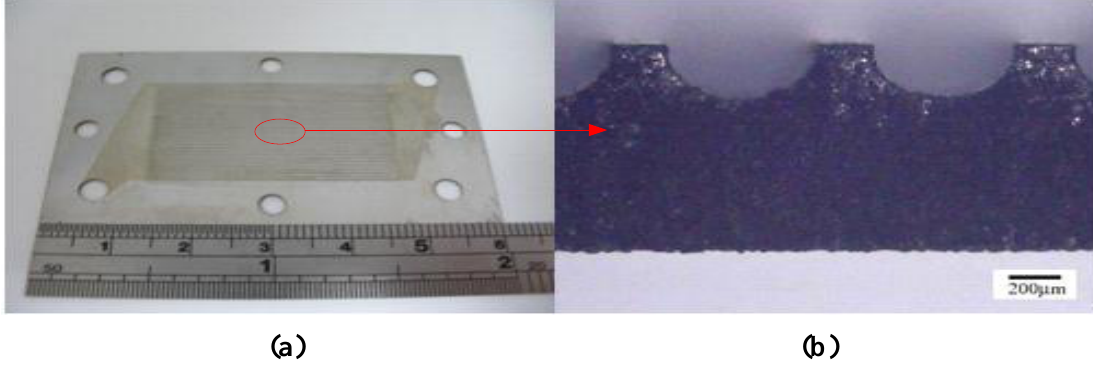
Figure 4. Planer micro flow plate: (a) surface; (b)